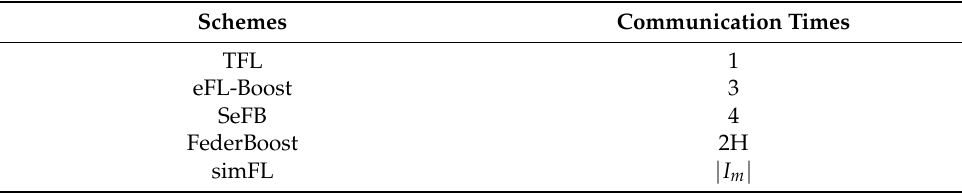
Table 2. Communication times required for each scheme to update the global model each time.